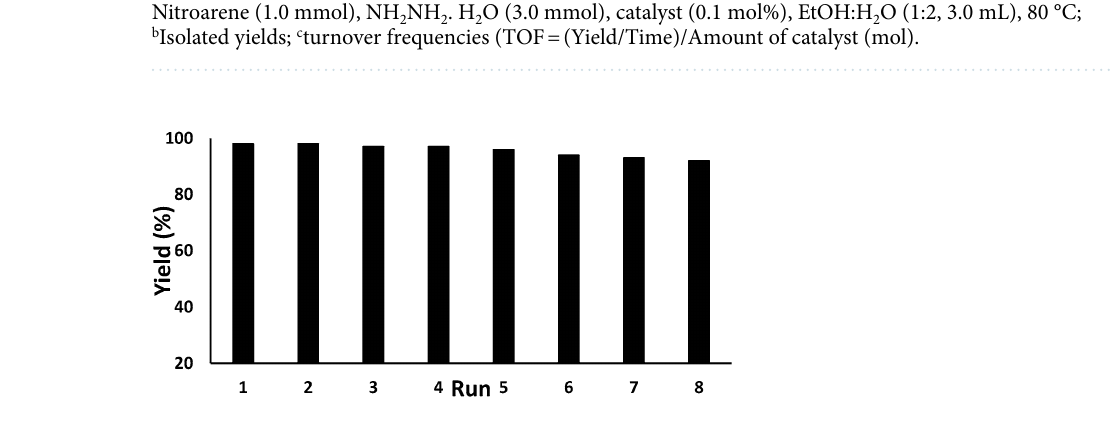
Table 2. Reduction of aromatic nitroarenes catalyzed by Fe 3 O 4 @ Fritillaria /Pd NPs a . a Reaction conditions: